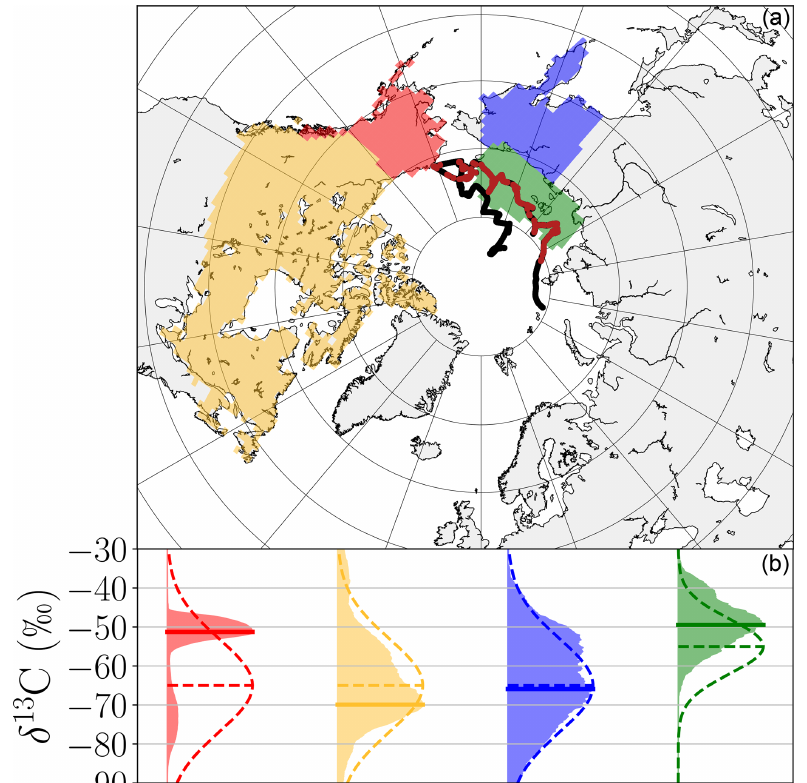
Figure 3. (a) Map of regions constrained by the observations in the inversion. For land regions, only wetlands are constrained. The green region corresponds to oceanic sources from the East Siberian Arctic Shelf. The ship path is indicated in black, with red points highlighting locations with available isotope observations. (b) Distribution of posterior hourly signatures as deduced by the inversion for regions con- strained by the observations for the ensemble of 8000 Monte Carlo inversions (see details in Sect. 2.3). Prior signature distributions (dashed lines) are those of Table 1. The optimal posterior signatures, defined as the maximum of the posterior distribution, are highlighted by plain horizontal